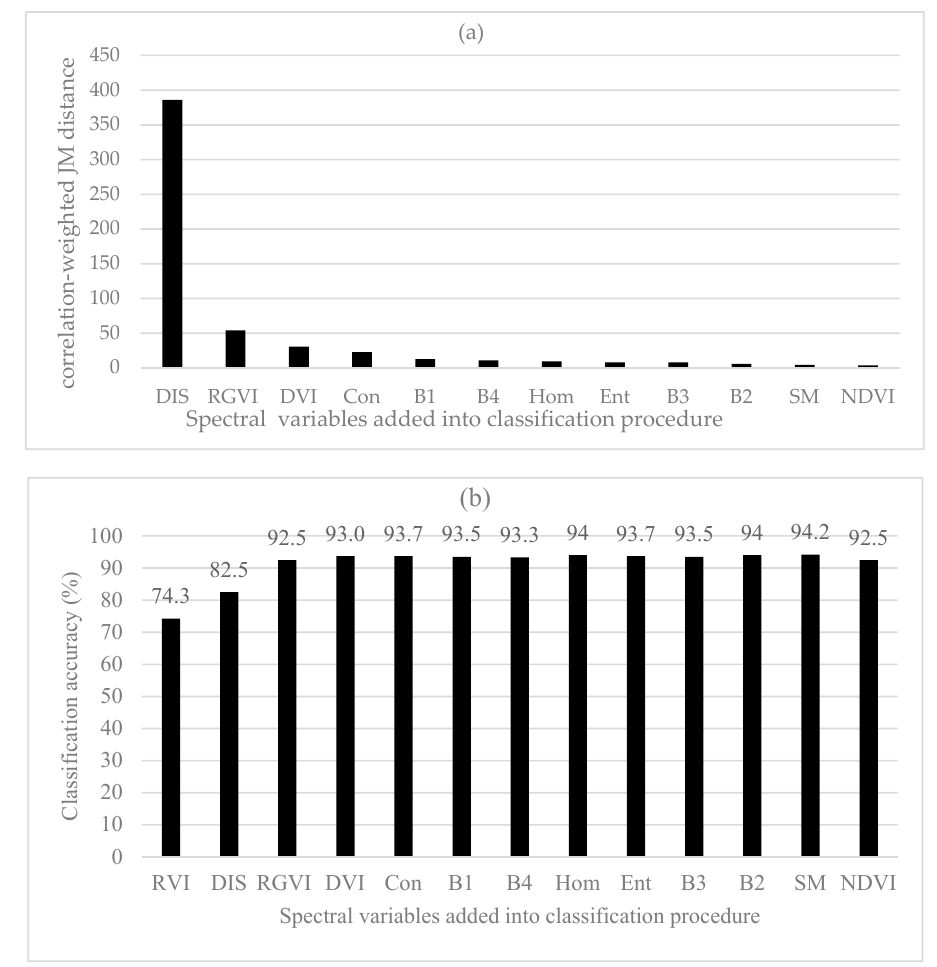
Figure 3. ( a ) The correlation-weighted Jeffreys–Matusita ( JM ) distance of the left 12 spectral variables orderly selected after the first spectral variable RVI; and ( b ) the classification accuracies of six land cover types using Bayesian discriminant ( BD ) classifier as the spectral variables orderly added based on the correlation-weighted JM distances.